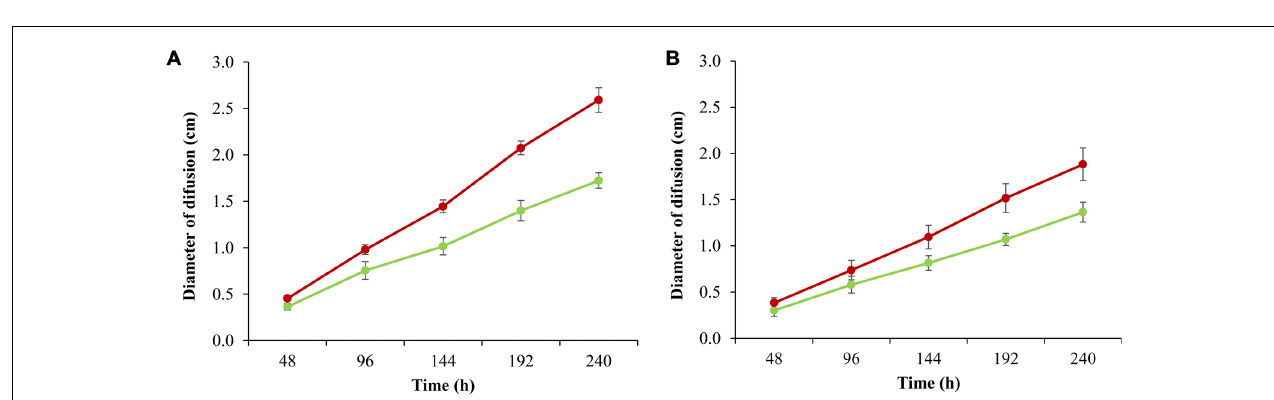
FIGURE 3 | Schematic flagellar structure of L. monocytogenes . Proteins involved are indicated. The graph shows the temporal transcriptional response at 8 ◦ C compared to 30 ◦ C for selected components (green lines: fast group, red lines: slow group; representing the same strains used in the microarray experiments). AC: Adapted culture (fast group: 4 days (cold adaptation) + 25 h (OD 600 nm = 0.3) = total time 121 h; slow group: 4 days (cold adaptation) + 32 h (OD 600 nm = 0.3) = total time 128 h).